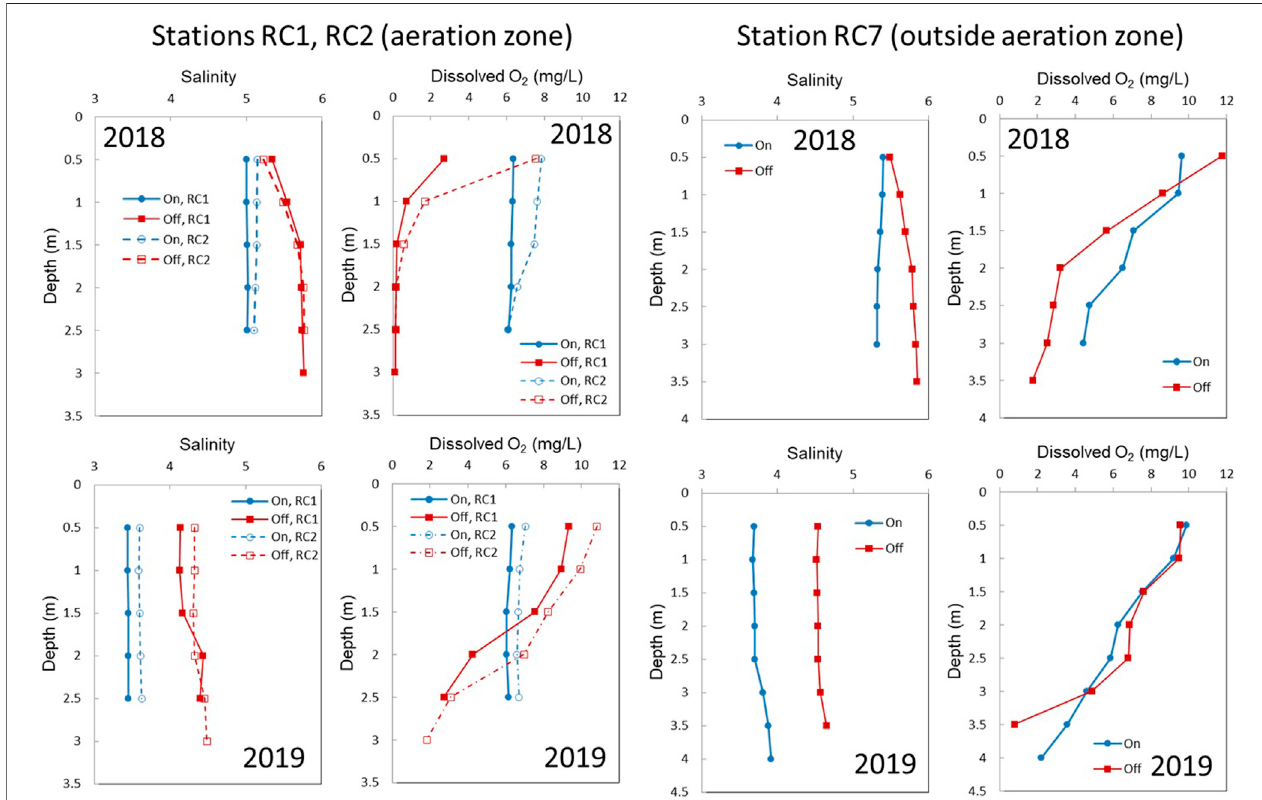
FIGURE 3 | Water column salinity and dissolved oxygen (O 2 ) pro fi les from 2018 (top panels) and 2019 (bottom panels) for stations within the aeration zone and stations outside the aeration zone. Blue symbols signify when aerators were ON and red when they were OFF.